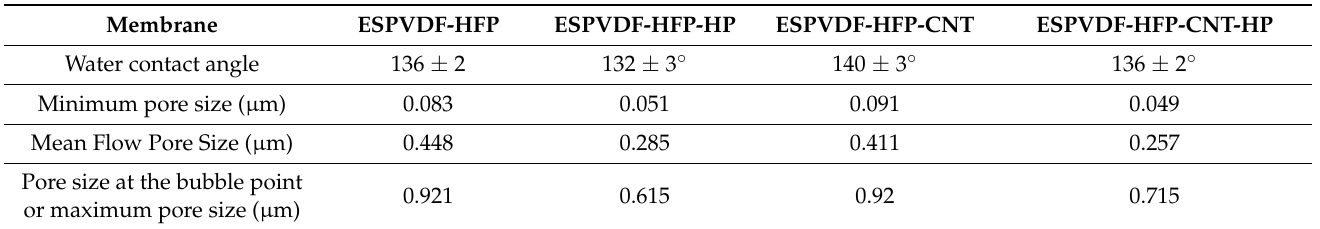
Table 2. Water contact angle and pore size distribution of the PVDF-Co-HFP and PVDF-Co-HFP- CNT membranes.